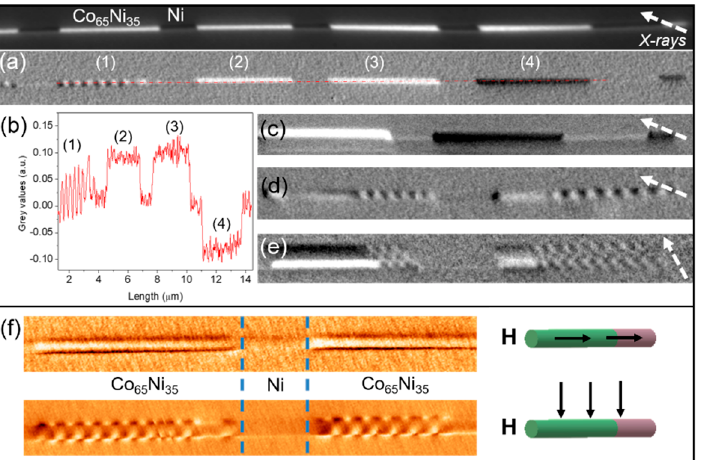
Figure 16. Chemical contrast of a multisegmented Co 65 Ni 35 /Ni nanowire (top panel). ( a ) XMCD-PEEM image of a Co 65 Ni 35 /Ni nanowire and ( b ) the contrast profile of CoNi segments in ( a ), labeled (1) to (4), with different magnetic structures. ( c – e ) XMCD-PEEM images of Co 65 Ni 35 /Ni nanowires showing different magnetic configurations. ( f ) MFM images taken in remanence (adapted from [75]), after applying a magnetic field of 1.8 T in the axial direction (top panel) and perpendicular to the nanowire (bottom panel).